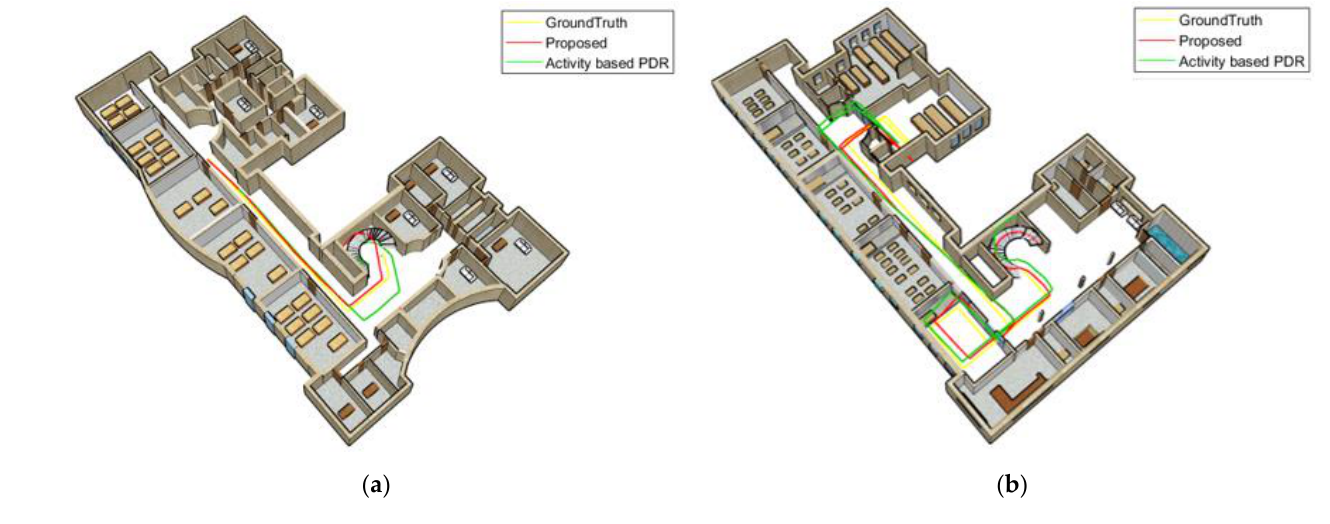
Figure 18. Texting woman; ( a ) third floor; ( b ) first floor.